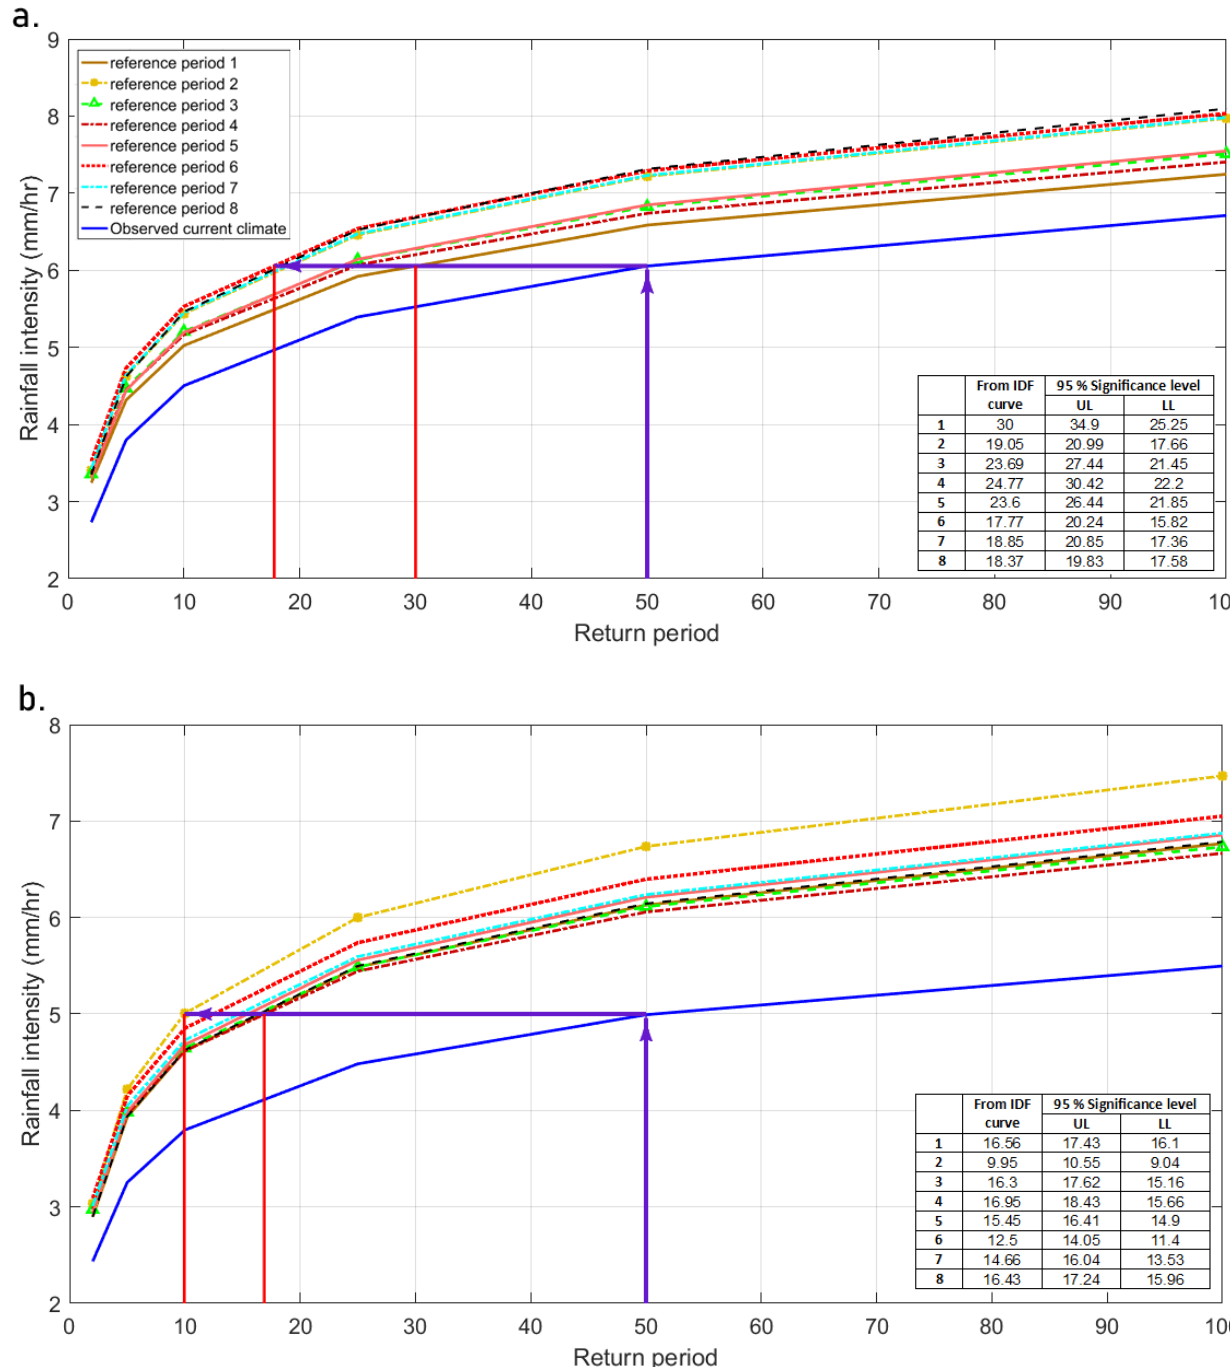
Figure 5. The rainfall intensity of current and future climates for 12 h duration and the 2 cases of disaggregation, case 1 ( a ), case 2 ( b ), and for different frequencies, and 8 reference periods.